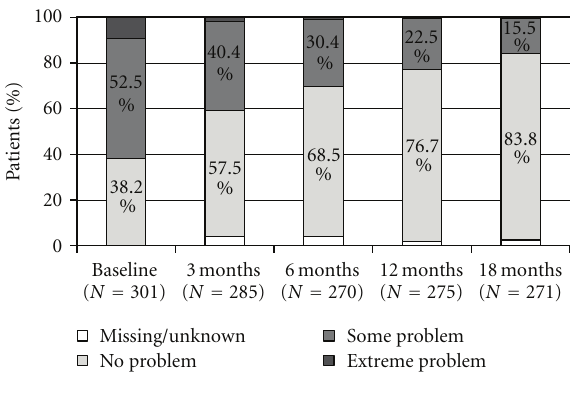
Figure 4: EQ-5D: mobility.